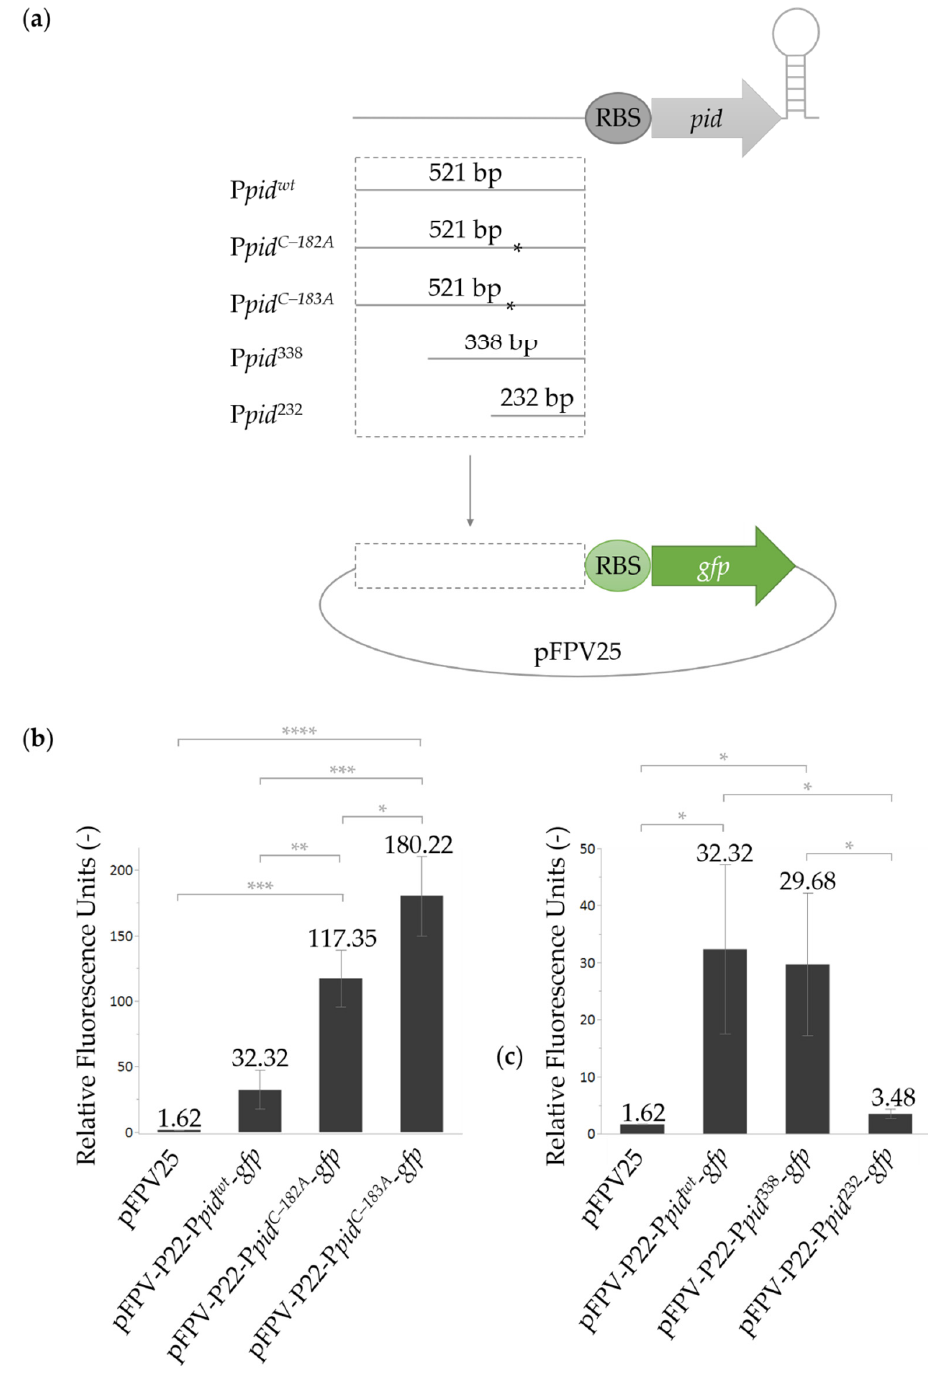
Figure 2. Assessment of the activity of the wild-type and mutant versions of the pid promoter. ( a ) Schematic of the different pid promoter variants constructed upstream of the gfp gene in the pFPV25 promoter probe plasmid. ( b , c ) GFP fluorescence stemming from AB-grown stationary phase cultures of LT2 equipped with the indicated reporter plasmids (panel ( b ): promoter mutations; panel ( c ): promoter truncations; as depicted in panel ( a )). Please note that pFPV25 and pFPV-P22-P pidwt -gfp are the same samples in panel ( b ) and ( c ). The mean fluorescence intensity relative to the OD 600 value is represented in bars, and the mean value and the standard deviation of three biological repeats are shown. The empty plasmid (pFPV25) was included as a negative control. Significant differences (Tukey HSD test) are indicated by * ( p ≤ 0.05), ** ( p ≤ 0.01), *** ( p ≤ 0.001), and **** ( p ≤ 0.0001).